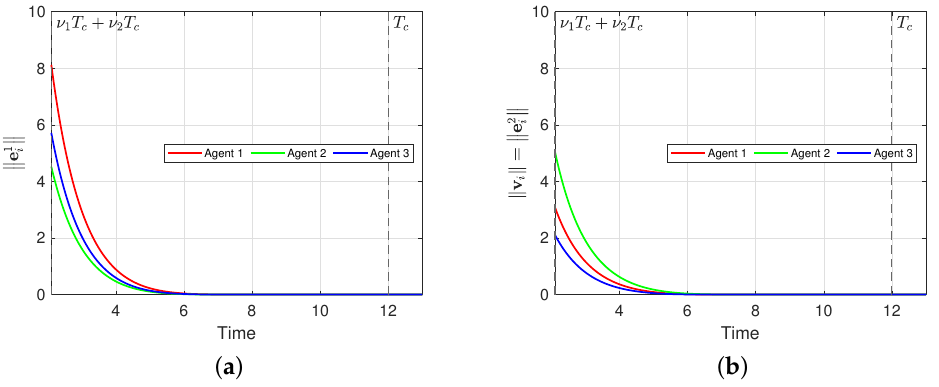
Figure 6. System evolution with respect to time in the presence of matched disturbances. ( a ) Norm of the tracking error in position. ( b ) Norm of the tracking error in